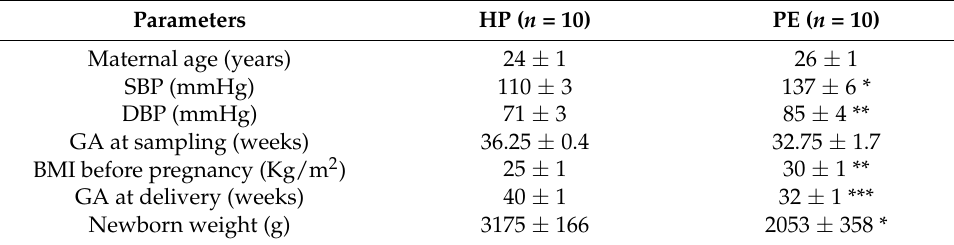
Table 1. Clinical parameters of HP and PE pregnant women enrolled in the study. Parameters HP ( n = 10) PE ( n = 10) Maternal age (years) 24 ± 1 SBP (mmHg) 110 ± 3 GA at sampling (weeks) GA at delivery (weeks) Newborn weight (g) 3175 ± 166 2053 ± 358